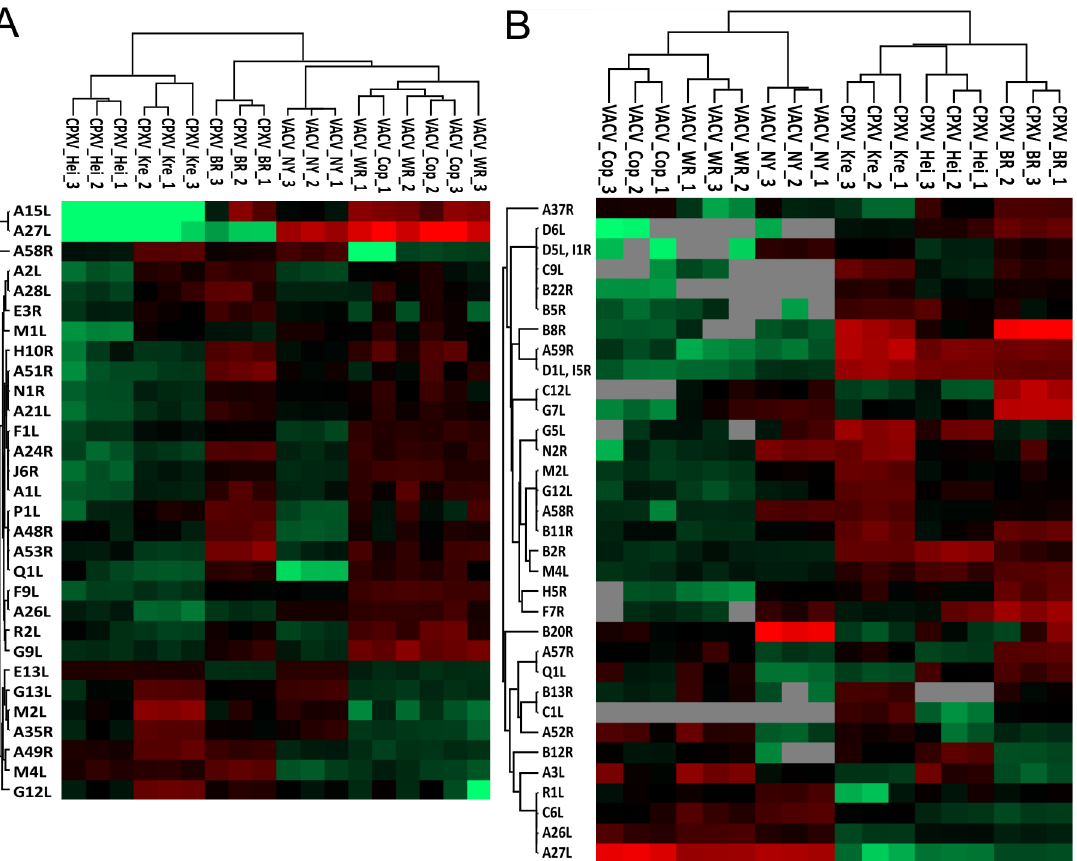
Fig 3. Strain-specific OPV mature virion proteins. The proteome composition of the mature virions was analyzed for strain-specific proteins using ANOVA tests with a permutation based FDR of 0.01 separately for the LFQ intensities and the normalized protein copy numbers. The abundance of strain-specific proteins identified by LFQ-based quantification is displayed in heatmap A, while strain-specific proteins according to protein copy numbers are shown in heatmap B. Red displays proteins whose abundance is above the mean protein abundance of the OPV homologues, green means abundance is below the mean and grey are missing values in the copy number approach. The proteins are named after the CPXV-GRI 90